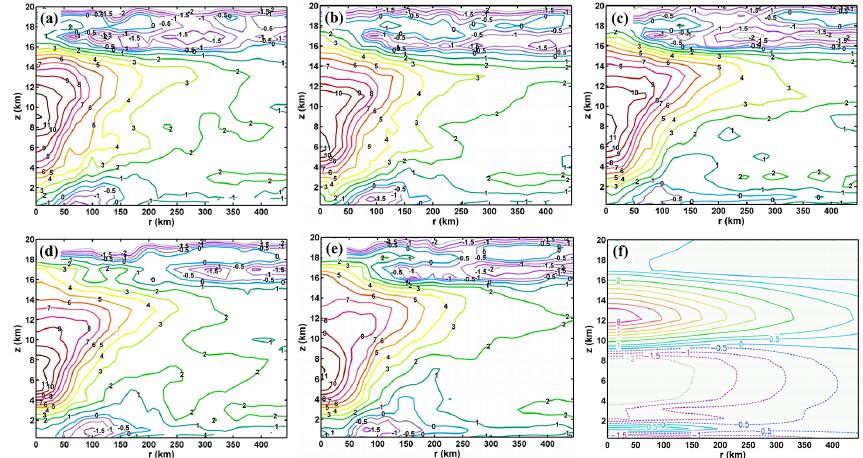
Figure 12. Depiction of the azimuthally averaged radius–height cross-section of temperature anomaly (K) for Phailin from experiments (a) CTL, (b) VARAMV, (c) VARRAD, (d) VARPREP, (e) VARPREP + RAD and (f) CIRA multi-satellite data at mature stage of the cyclone corresponding to 06:00UTC 12 October 2013. Here, r is the radius from the centre of the cyclone and z is the height.